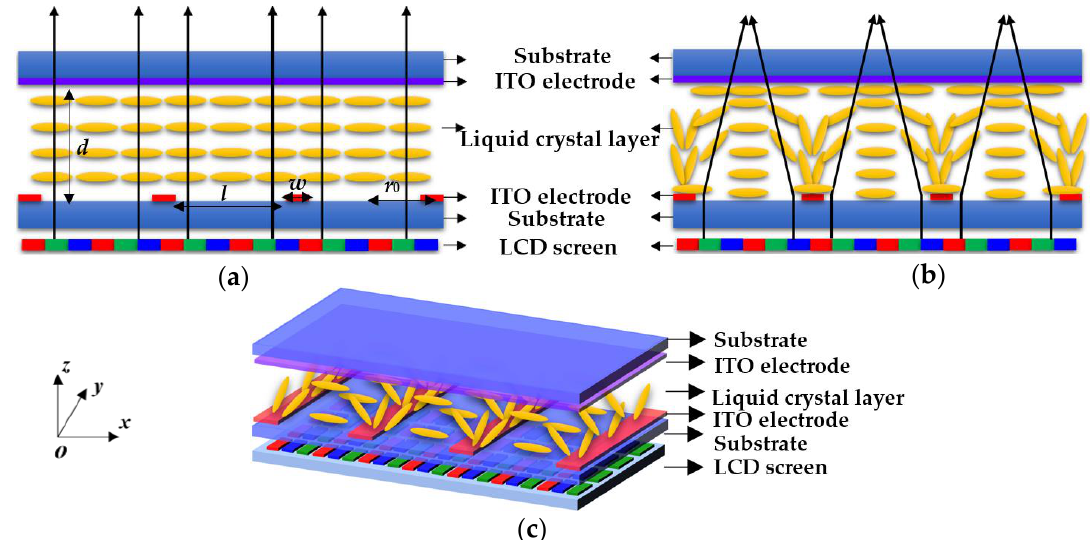
Figure 1. Structure of the 2D/3D switchable display based on the cylindrical LC lens array in the ( a ) 2D mode and ( b ) 3D mode and ( c ) stereogram of 3D mode.